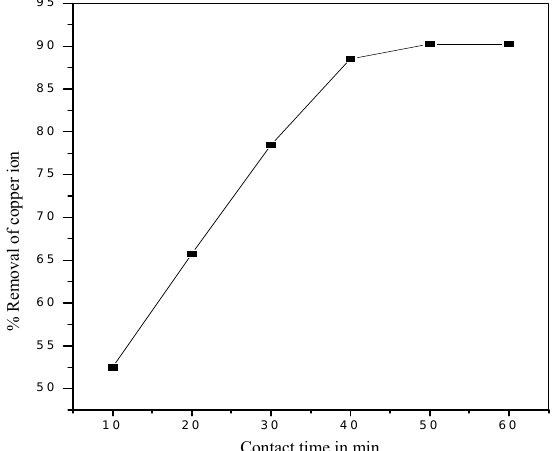
Figure 2 . Effect of contact time on the adsorpton of copper ion by CBC [Cu]=30 mg/L; adsorbent dose=25 mg/50 mL; temp=35 o C